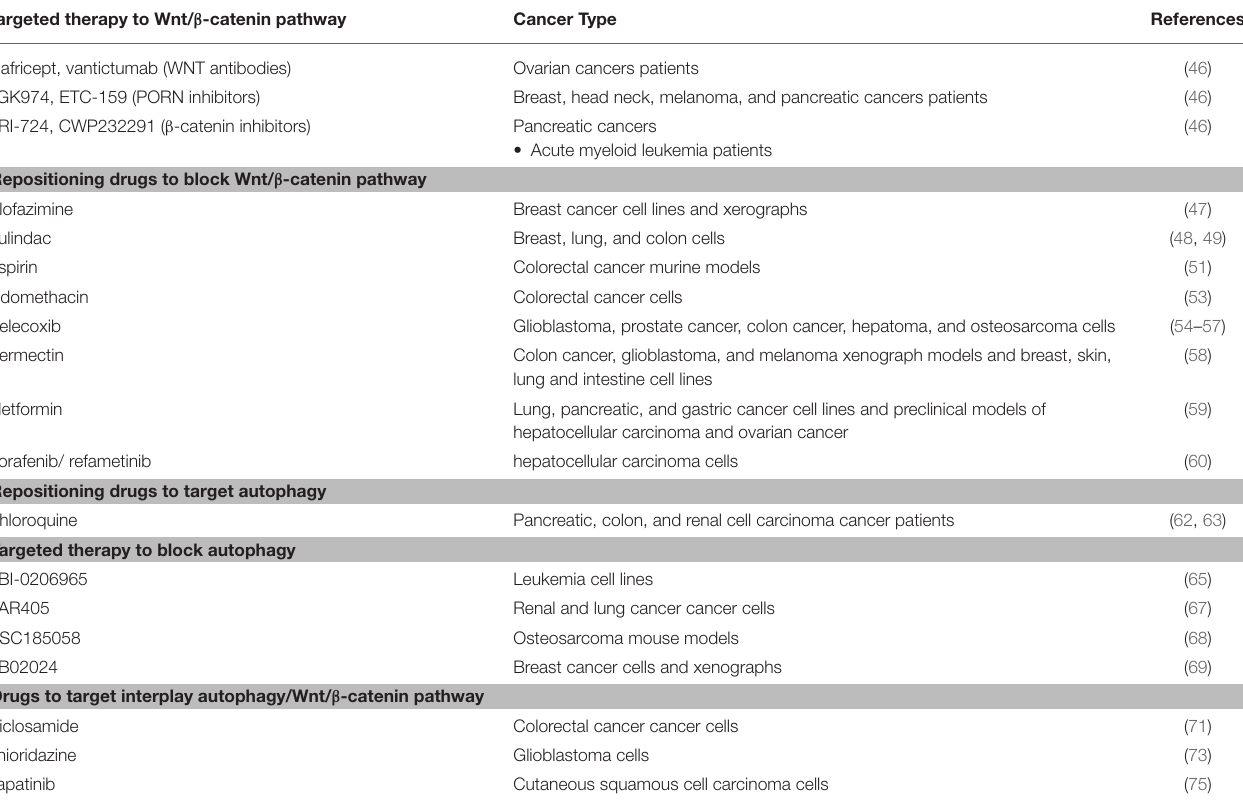
TABLE 1 | Targeted therapy and repositioning drugs to block Wnt/ β -catenin and autophagy. Targeted therapy to Wnt/ β -catenin pathway Cancer